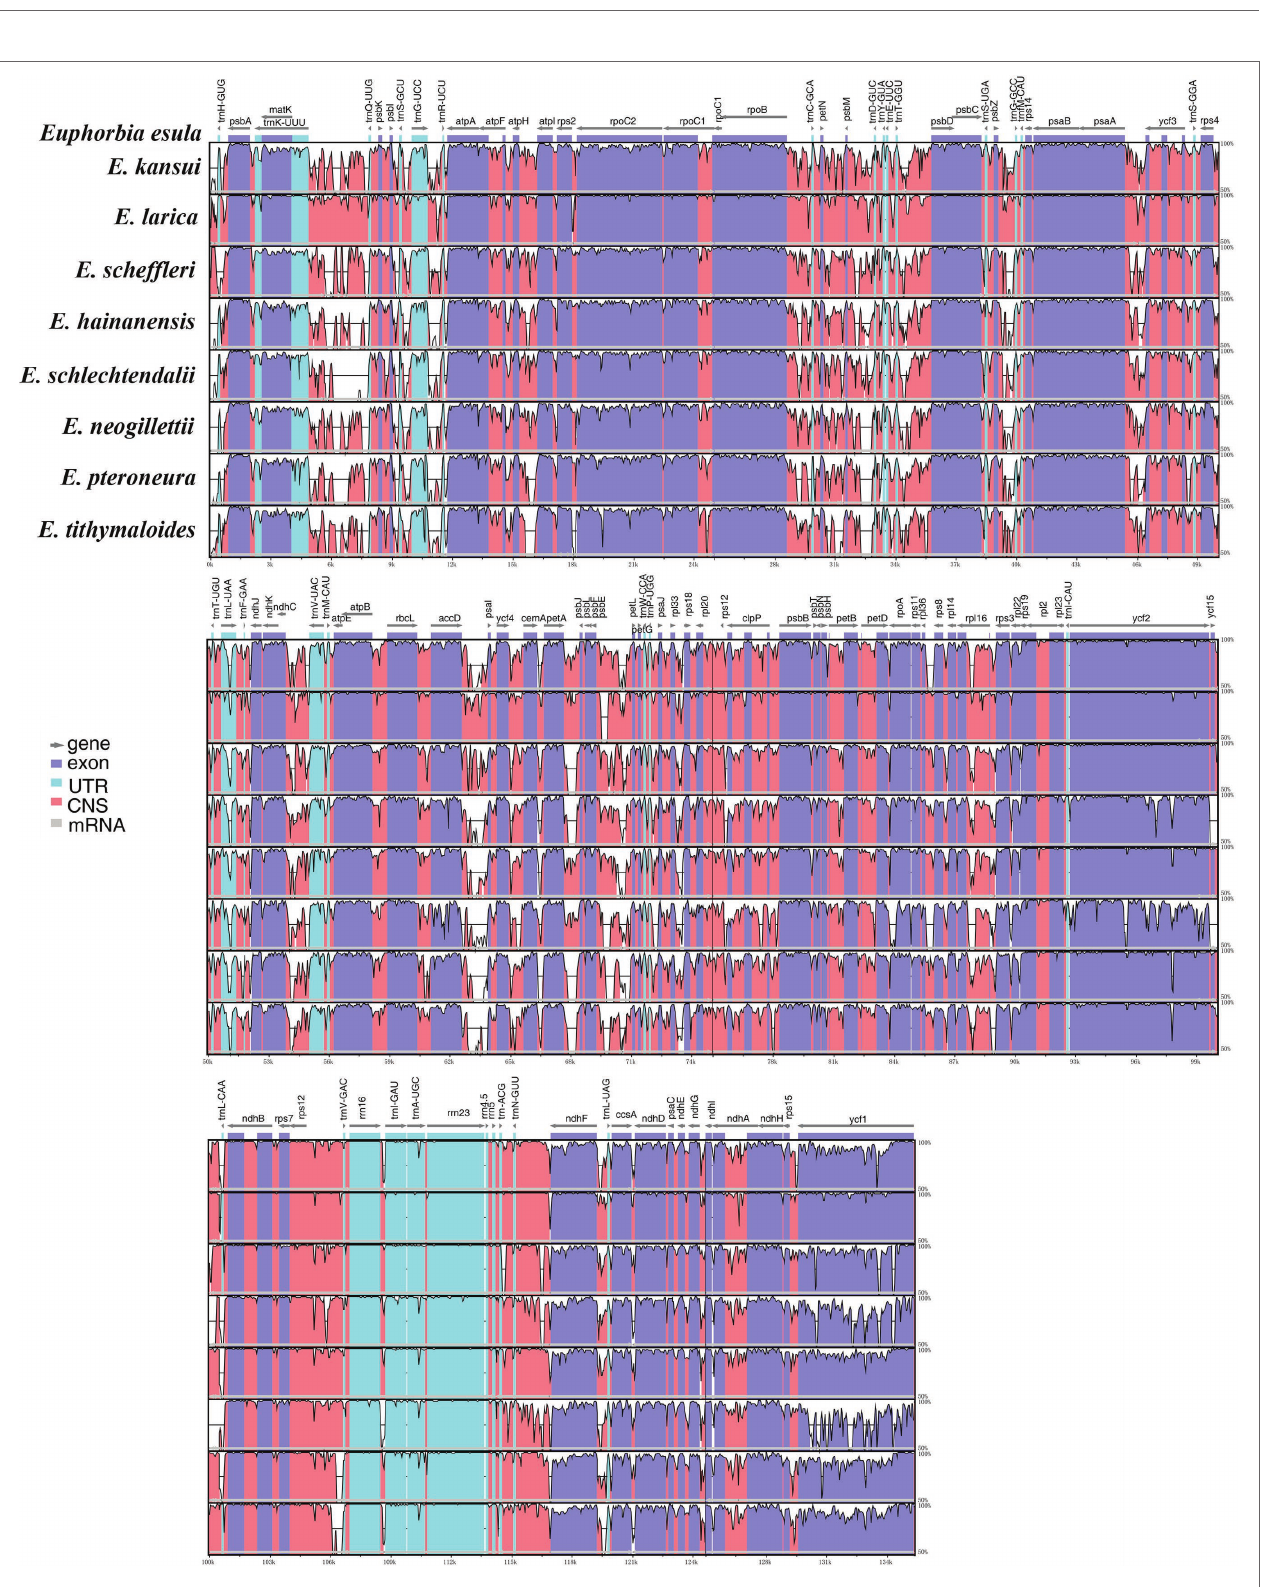
FIGURE 4 | Visualized alignments of nine plastomes representing four subgenera of Euphorbia using mVISTA, with E. esula as the reference and only one copy of the inverted repeat regions shown. The horizontal axis represents the base sequence of the alignment, and the vertical scale represents the pairwise percent identity, ranging from 50 to 100%. Gray arrows above the alignment indicate genes and their orientations. Dark-blue boxes represent exon regions; light-blue boxes represent Untranslated Region (UTR) regions; red boxes represent non-coding sequence (CNS) regions; gray boxes represent mRNA